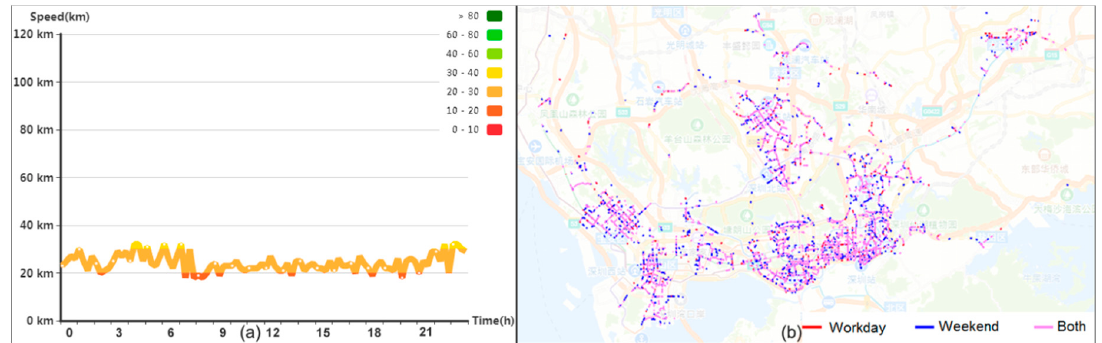
Figure 6. Most common pattern of all road links during a month. ( a ) The most common traffic pattern and ( b ) the road links with similar patterns.